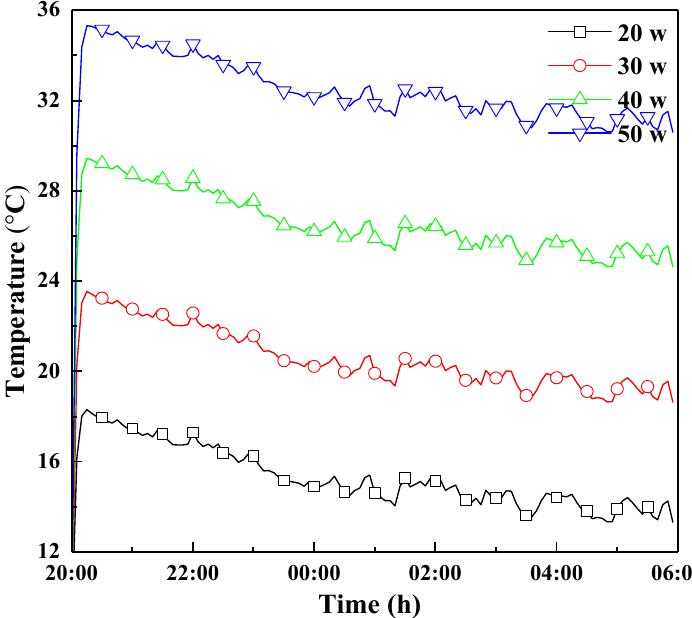
Figure 17. Time-dependent variation of the component surface temperature with different heating outputs.